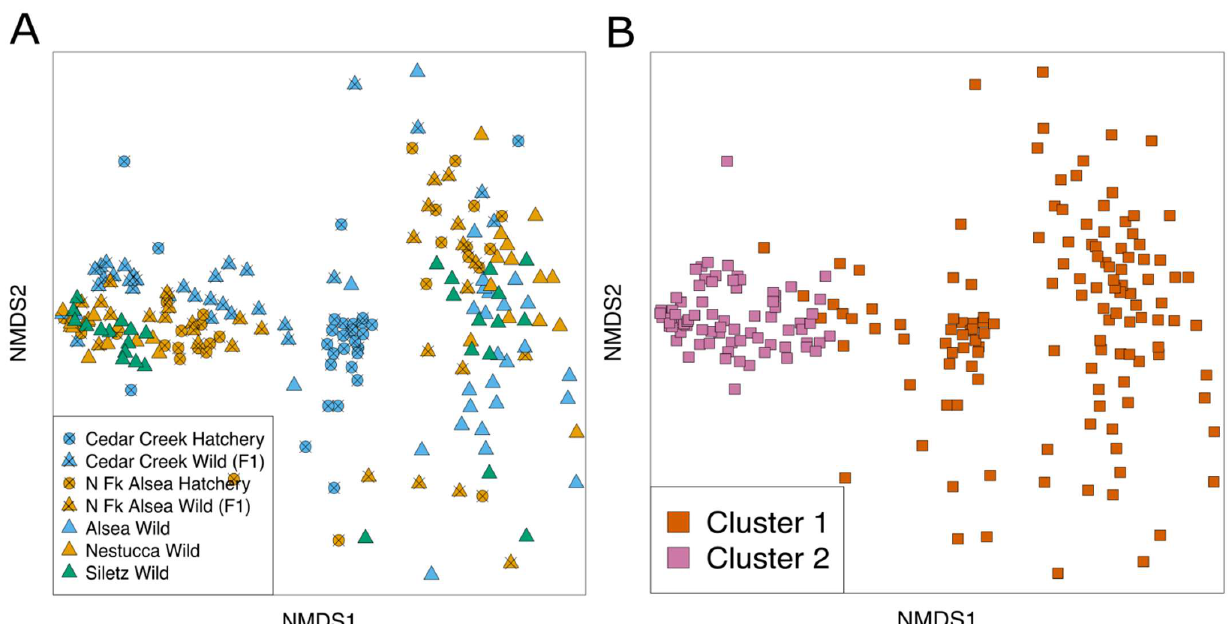
Figure 8. NMDS plots and PAM cluster analysis reveal two clusters that may represent two steelhead gut microbiome types. ( A ) shows the combined NMDS visualization of all wild-born and hatchery-reared steelhead gut microbiome samples. The samples aggregate into two groups separated by space in the ordination. The coloring based on river basins and the shapes based on management type indicate that neither of these variables separates out into these two clusters. ( B ) colors each microbiome sample based on the PAM cluster designation and shows that PAM cluster assignment corresponds with the two speculated clusters.